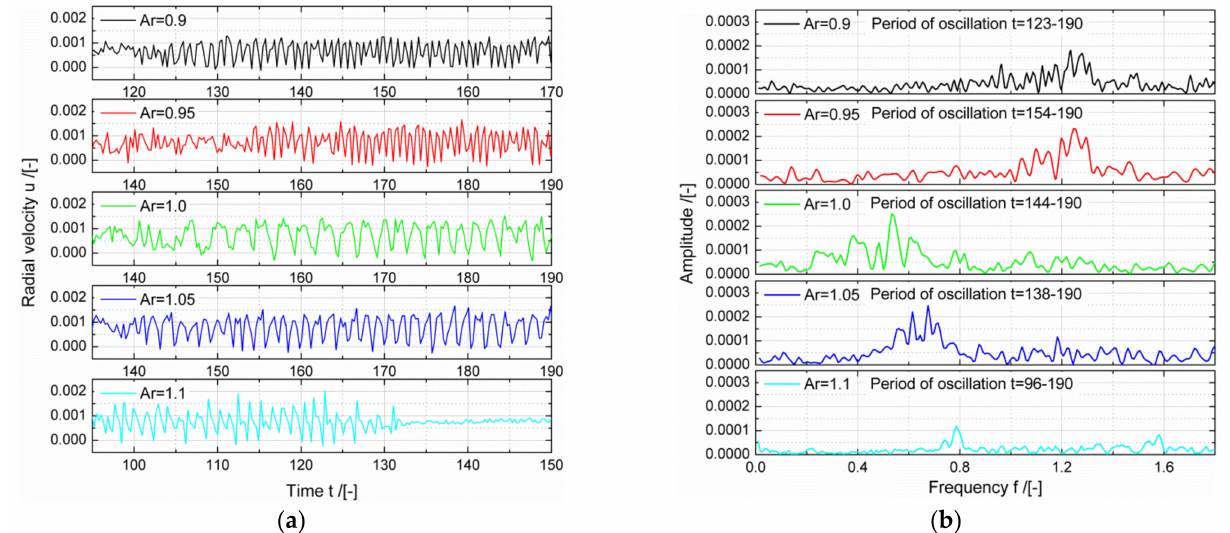
Figure 11. ( a ) Radial velocity oscillations at monitoring point h with different aspect ratios; ( b ) FFT spectra of radial velocity oscillations ( Ca C = − 0.01, R = 2.5 mm, H/R = 0.9, 0.95, 1.0, 1.05 and 1.1, Vr = 1.0).